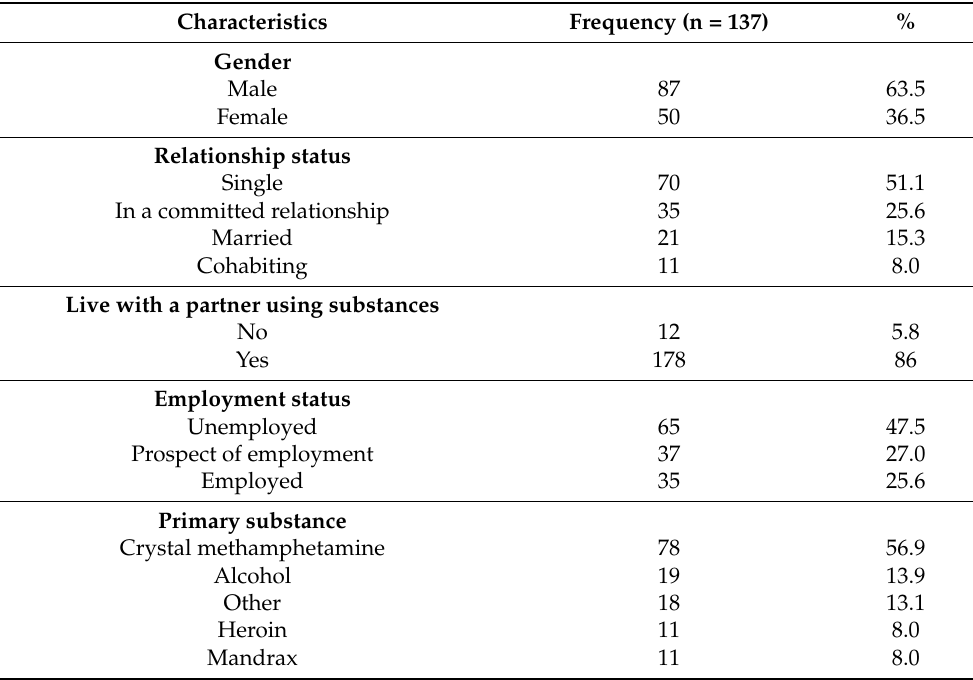
Table 2. Characteristics of the follow-up sample (n =